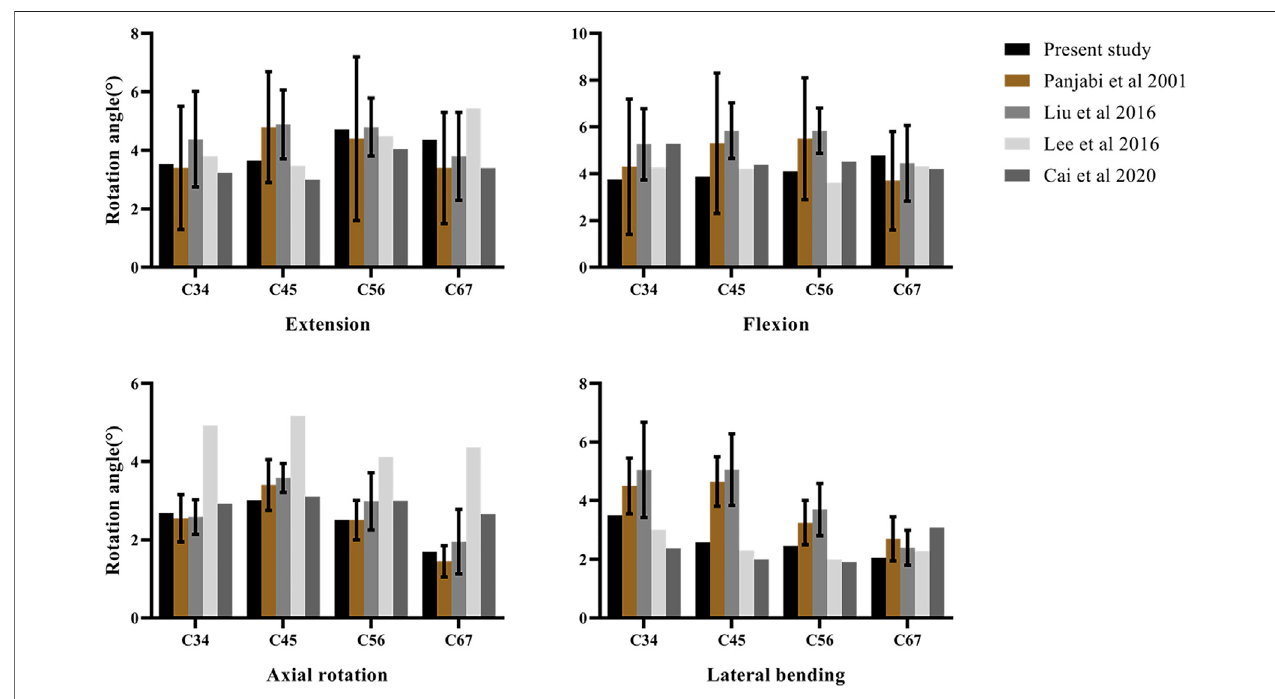
FIGURE 3 | Validation of the intact C3 – C7 fi nite element model.